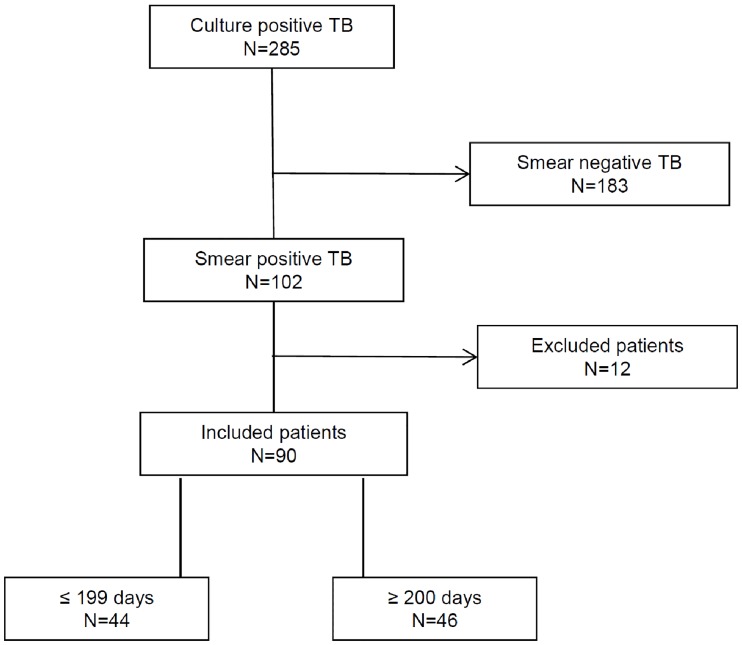
Flow chart showing the participants included in the analysis.